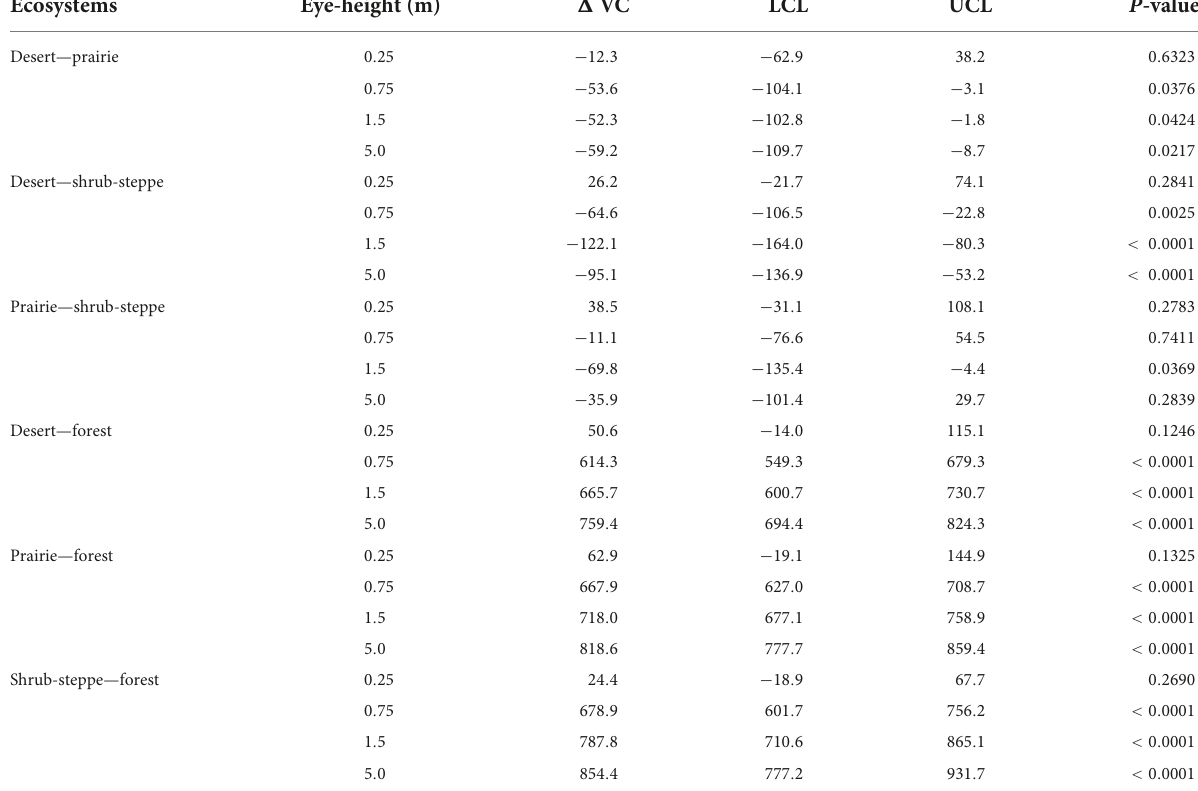
TABLE 2 Viewshed coefficients across ecosystems.